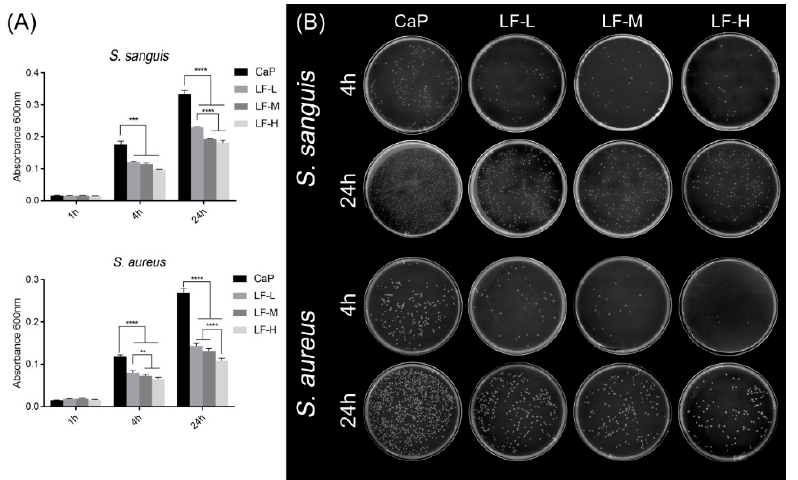
Figure 6. ( A ) Proliferation of S. sanguis and S. aureus cultured on CaP, LF-L, LF-M, and LF-H samples for 1, 4, and 24 h. ** p < 0.01; *** p < 0.001; **** p < 0.0001.( B ) S. sanguis colonies and S. aureus colonies on the agar plates, which were incubated with CaP, LF-L, LF-M, and LF-H samples for 4 and 24